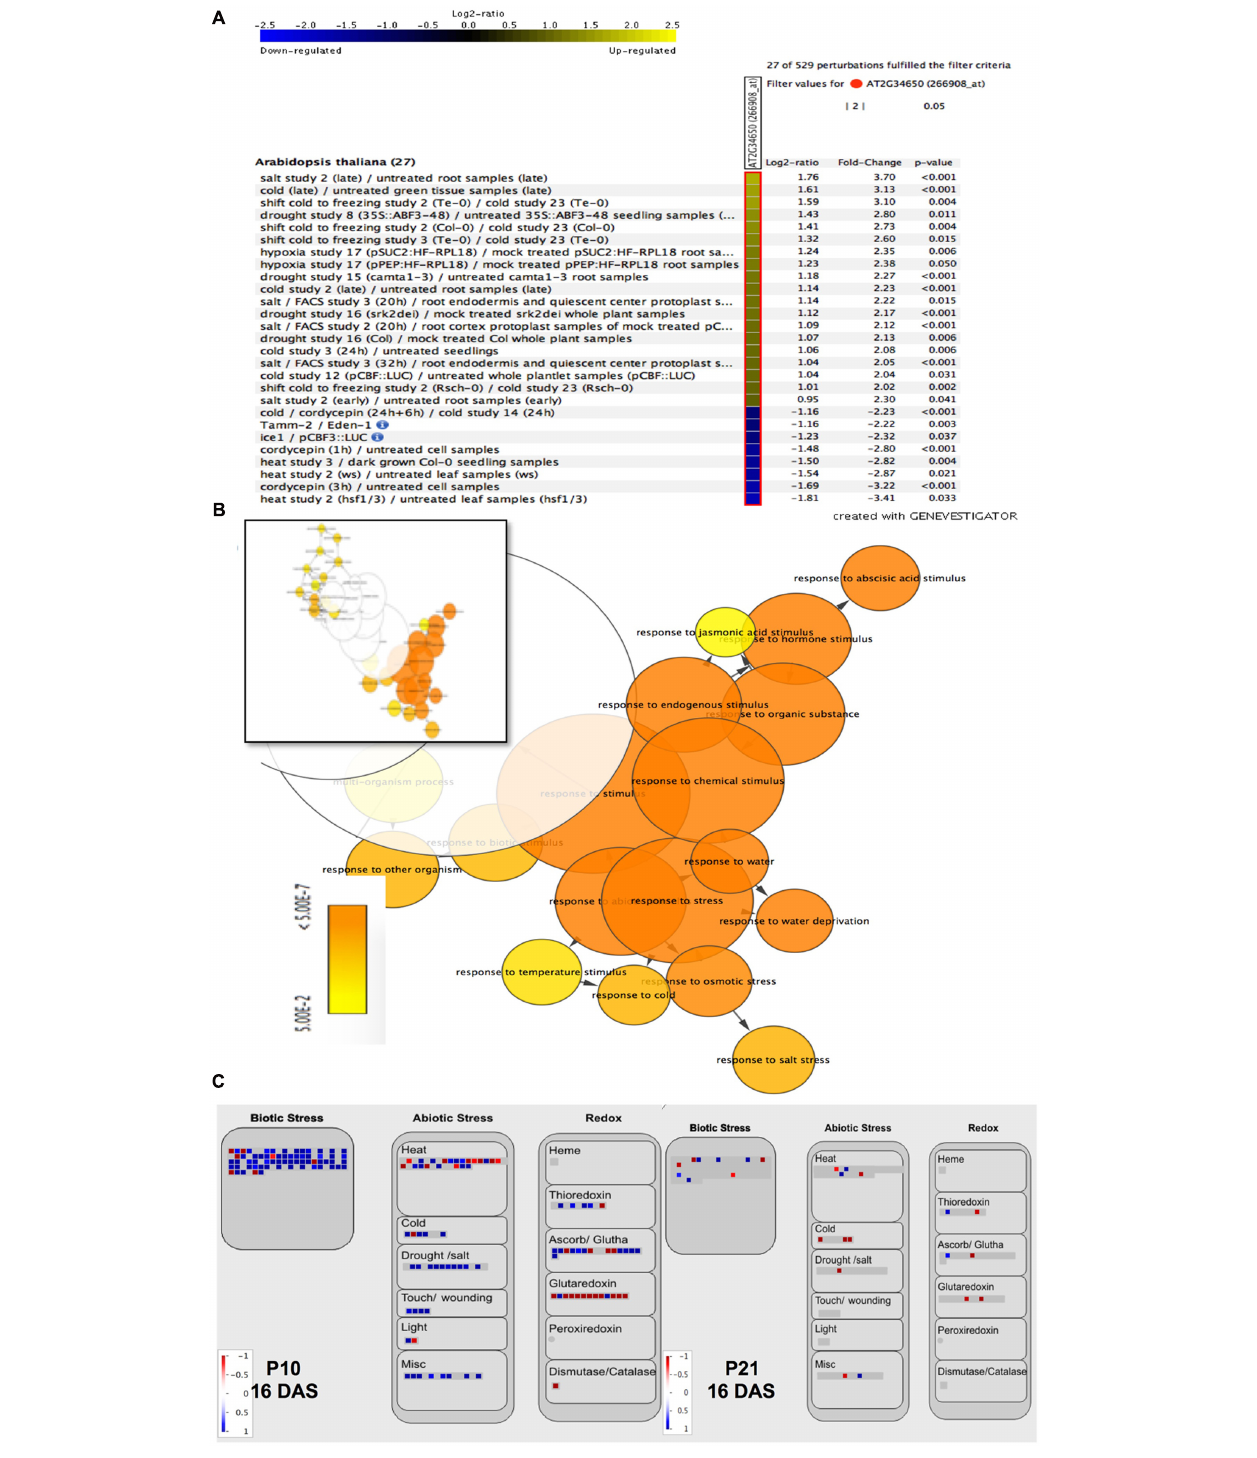
FIGURE 2 | Effect of abiotic stress on PID expression levels and of PID overexpression on stress-related genes. Genevestigator analysis shows up- (yellow) and downregulation (blue) of PID under various abiotic stress conditions (A) . Gene enrichment analysis of differentially expressed genes in PID overexpression lines vs. WT, visualized via the Cytoscape plugin BiNGO. The inset shows a representation of all 3805 genes, while the major overrepresented genes (orange part of the inset) are magnified (B) . MapMan analysis of up- (blue squares) and downregulated (red squares) genes in P10 and P21 at 16 DAS compared to WT, shows the upregulation of biotic and abiotic stress-related genes and changes in redox status (C) .